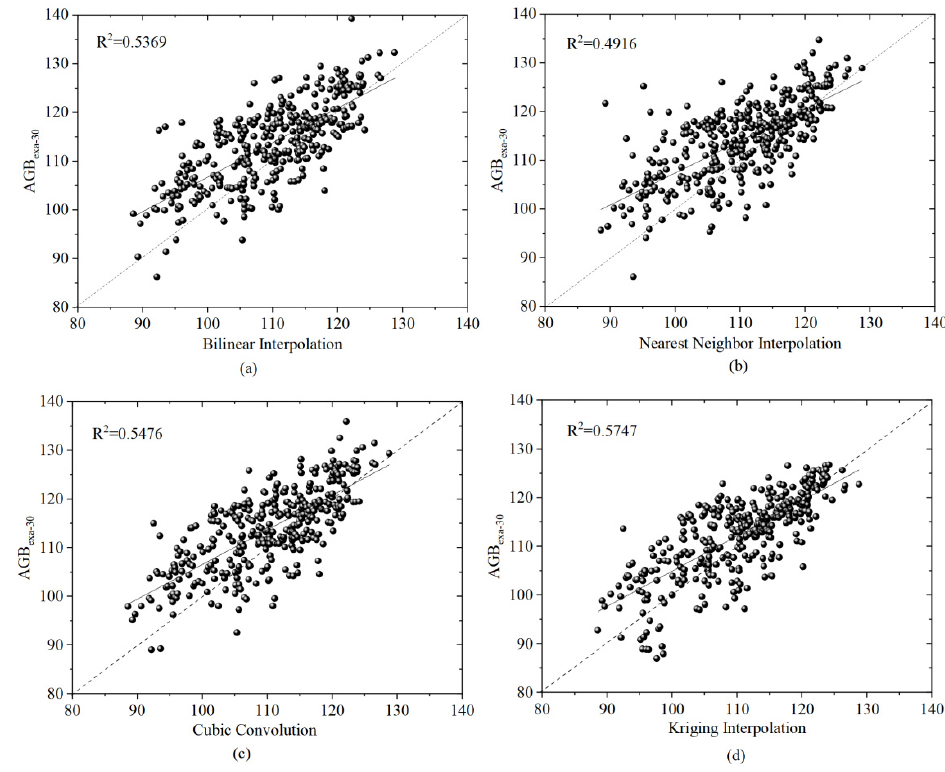
Figure 11. Accuracy evaluation among geostatistical scale-corrected AGB results at 30 m resolu ‐ tion.